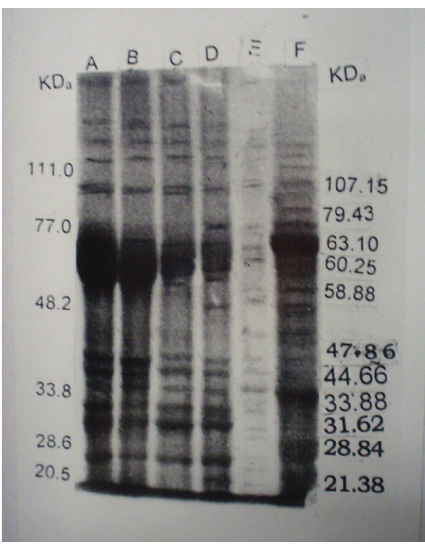
Figure 1: SDS-PAGE analysis of whole cell and sonicated super- natant antigens. Lane A: WCA of M. agalactiae RPNS 216. Lane B: WCAof M. agalactiae RPNS210. LaneC:SSAof M. agalactiae RPNS 216. Lane D: SSA of M. agalactiae RPNS 210. Lane E: SSA of M. bovis NC 317. Lane F: WCA of M. bovis NC